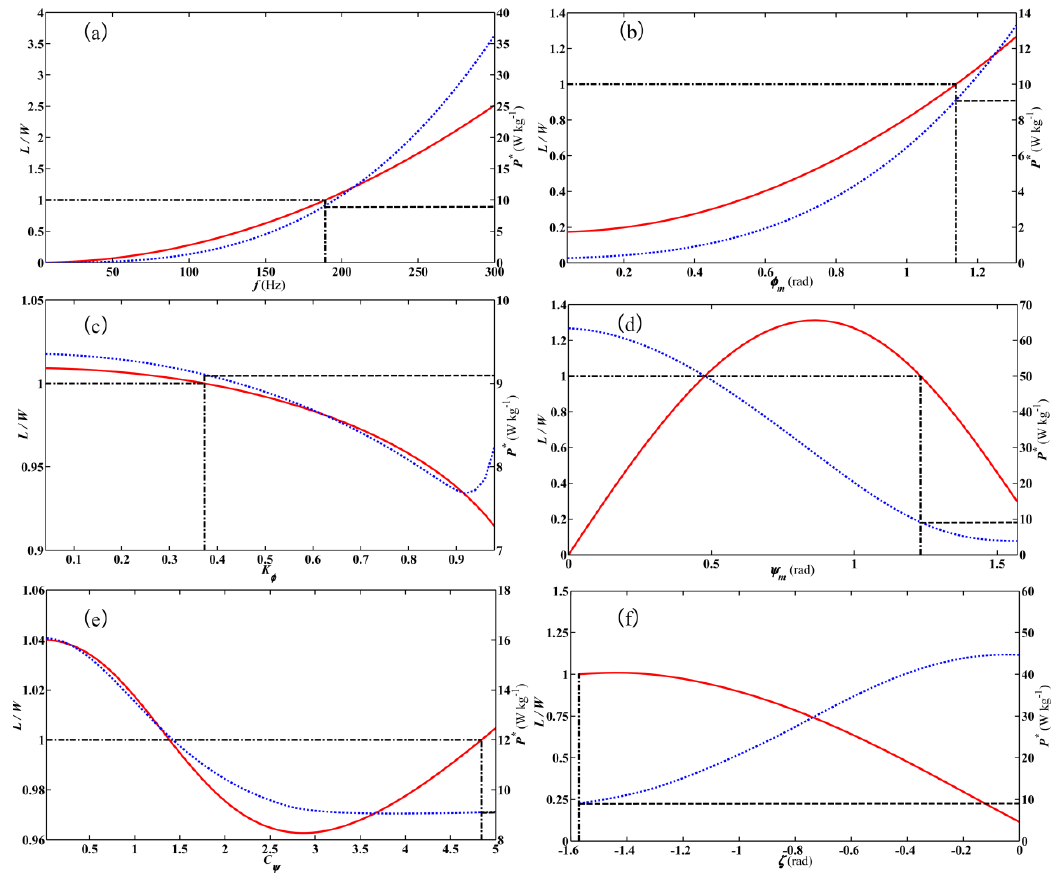
Figure 10. ( a – f ) Single ‐ parameter sensitivity analyses for optimal wing kinematics parameters (WKP). The layout is identical to Figure 8.